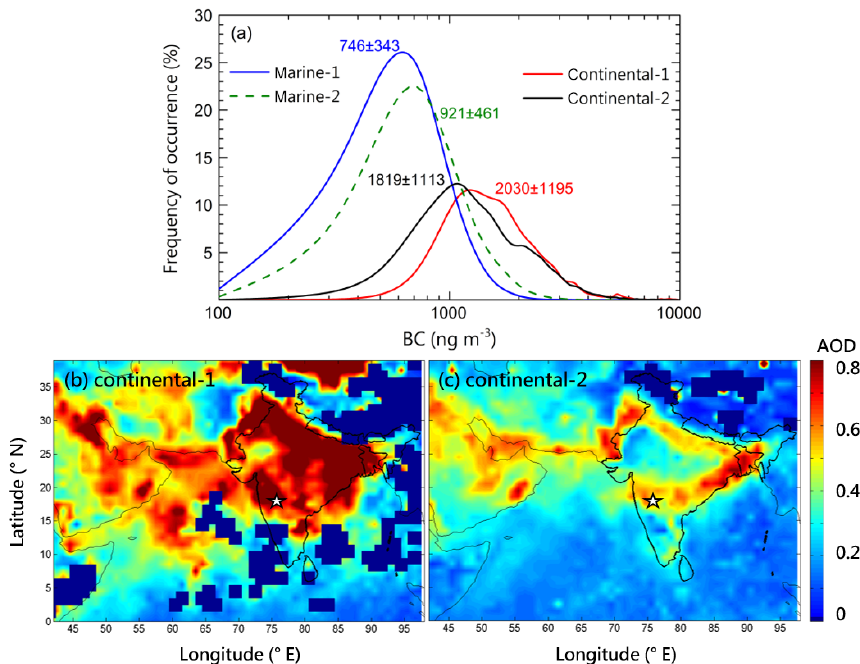
Figure 3. (a) Frequency distribution of BC mass concentration and its mean values for marine and continental conditions. Aerosol optical depth (AOD) at 550nm observed from the Moderate Resolution Imaging Spectroradiometer (MODIS) for the (b) continental-1 and (c) continental-2 conditions. The Solapur site is indicated by the star in the spatial AOD